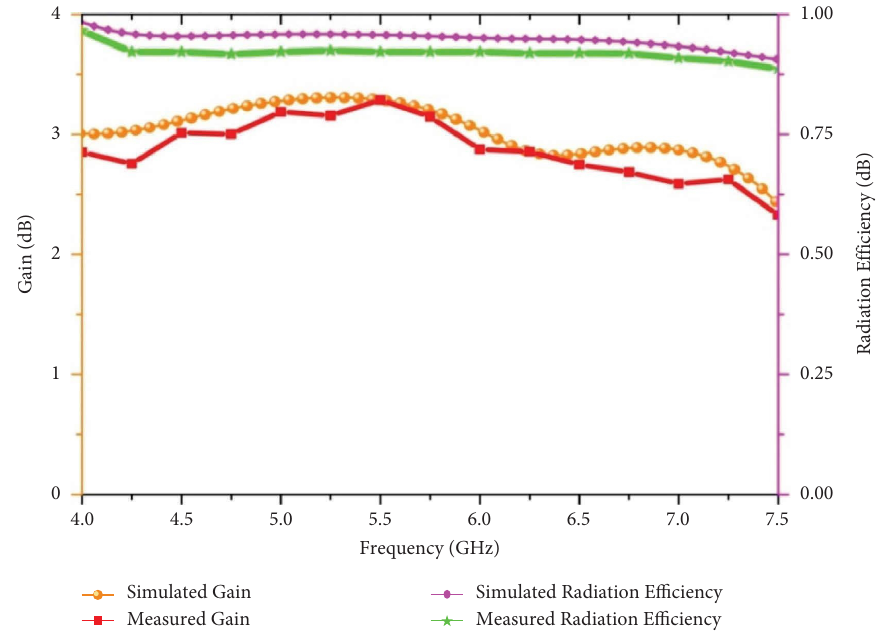
Figure 11: Gain and radiation